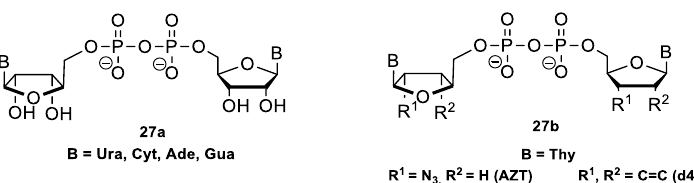
Figure 3. Homodinucleotides obtained by Sun et al. via pyridinium phosphobetaine intermediates.